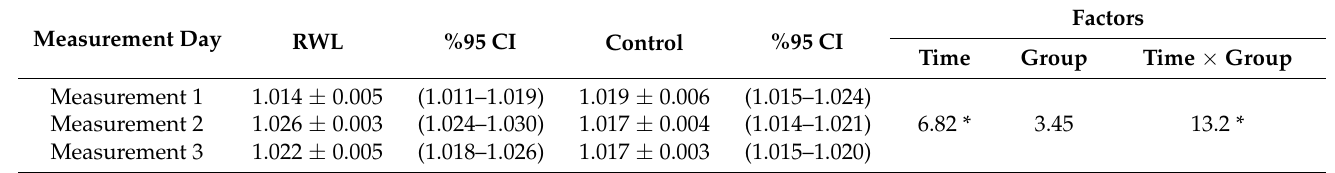
Table 2. Changes in USG values in RWL and control groups among measurements.